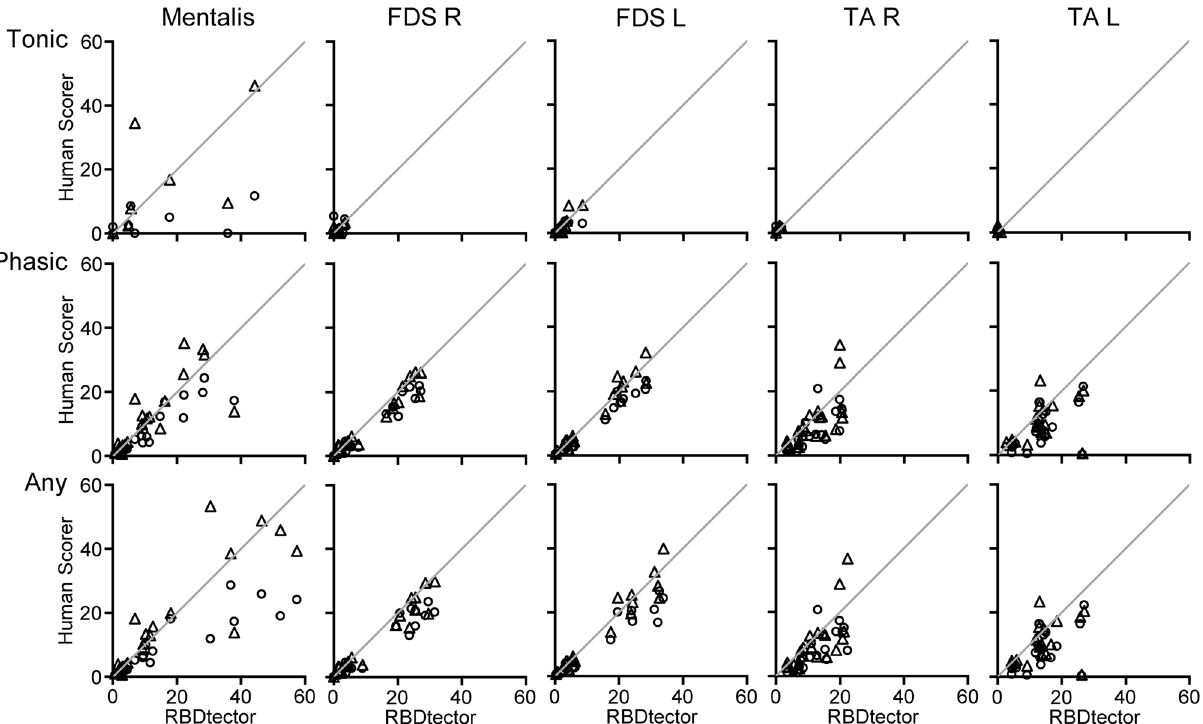
Figure 1. Correlation plots of the RBDtector scorings of the percentage of tonic, phasic, and any muscle activity in five different muscles during REM sleep against two human scorers (triangle, expert scorer and circles, novice scorer). Line of unity in light grey. FDS flexor digitorum superficialis muscle, TA tibialis anterior muscle, R right, L left.